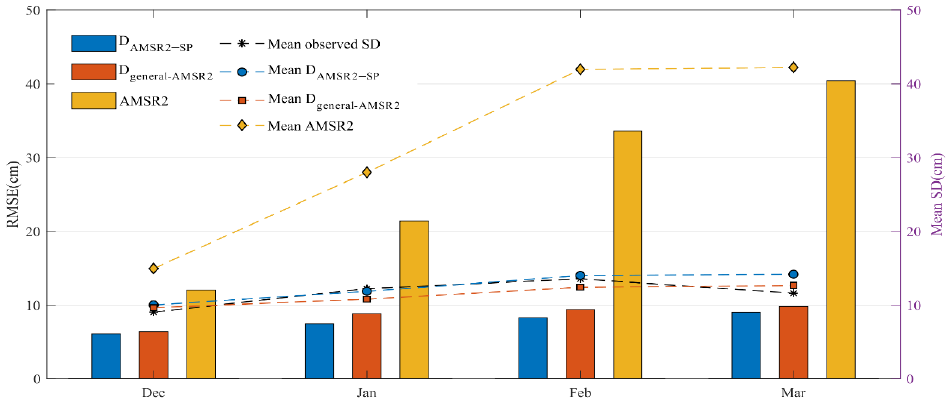
Figure 11. Monthly RMSE variations for the multifactor SD downscaling model. The corresponding dashed lines represent the monthly mean SD.